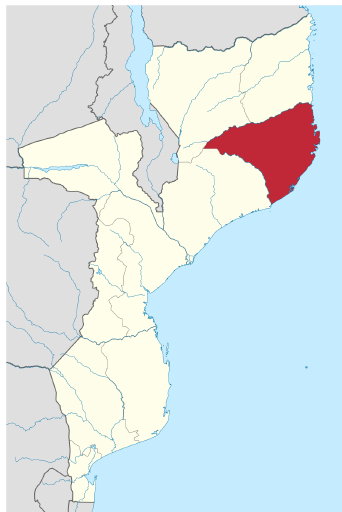
Figure 1. Territory of Mozambique and of the Nampula Province, in red. (Source: Wikimedia Commons, license CC BY-SA 3.0)